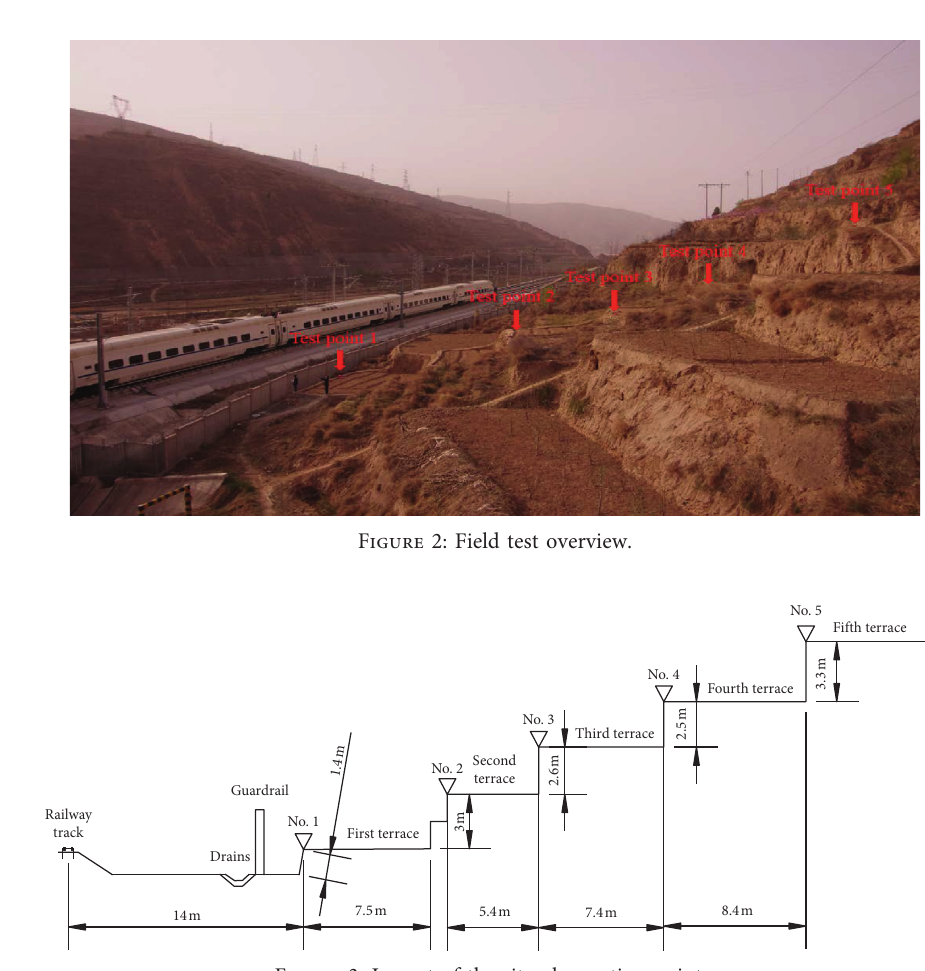
Figure 3: Layout of the site observation